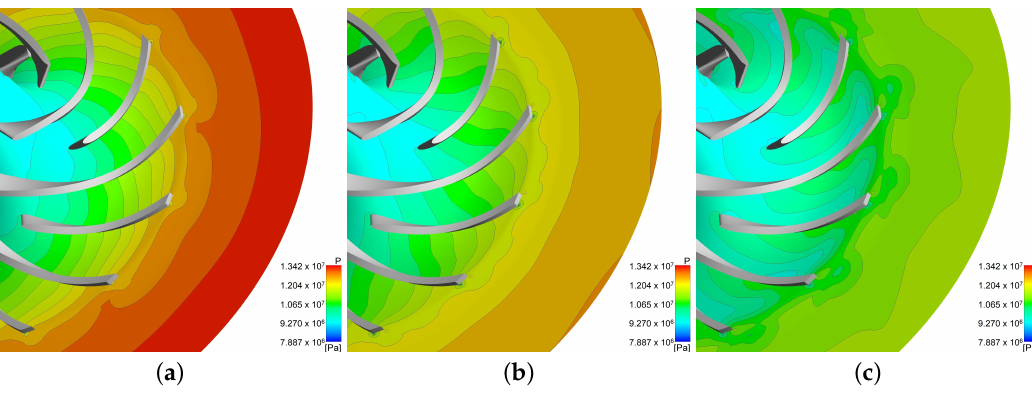
Figure 18. Pressure contour at span 50% span of impeller with vaneless diffuser. ( a ) Vaneless diffuser at mass flow rate of 1.4 kg/s. ( b ) Vaneless diffuser at mass flow rate of 2.9 kg/s. ( c ) Vaneless diffuser at mass flow rate of 4.5